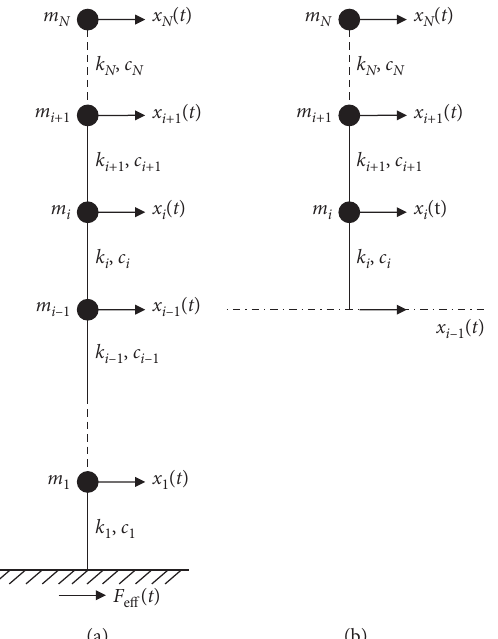
Figure 1: (a) Original complete structure and (b) the i th substructure (reproduced from Lin et al. [8], under the Creative Commons Attribution license/public